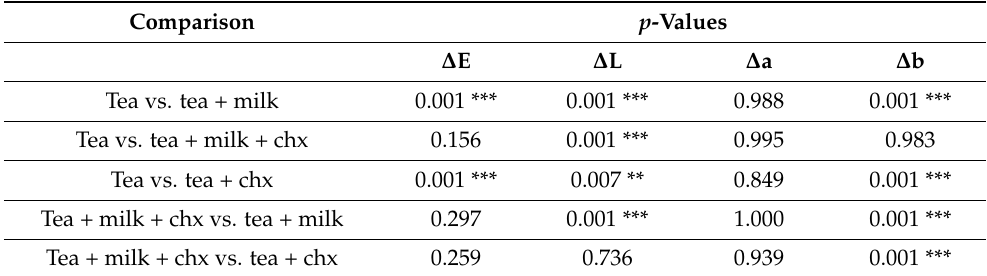
(Table 3). The color change in the tea + milk + chlorhexidine and tea + chlorhexidine groups was from black toward white (Table 3). Color changes in all groups were toward green in the ∆ a. Regarding ∆ b, the descriptive statistics indicate that the color change for tea + milk was toward blue on the yellow–blue scale, whereas this change was towards yellow for the Further statistical comparisons of ∆ E, ∆ L, ∆ a and ∆ b are presented in Table 4. Table 4. Comparison of tea solutions with or without milk and/or chlorhexidine.